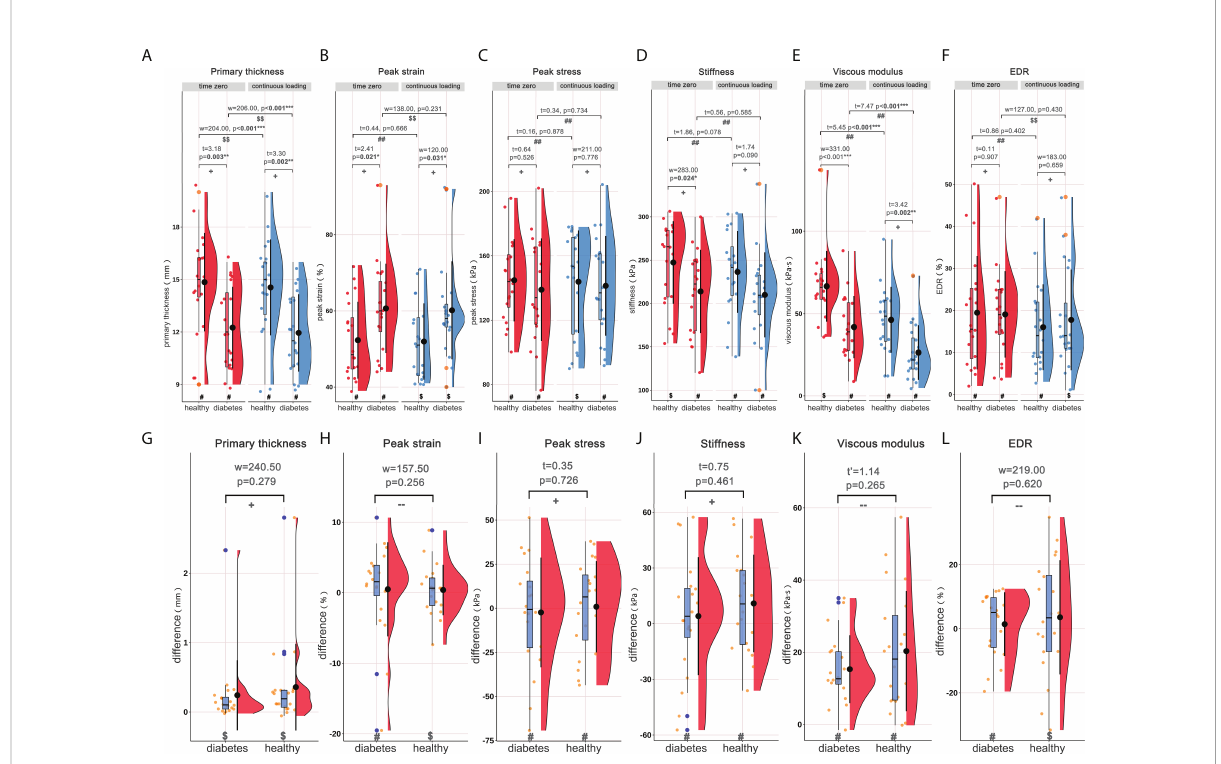
FIGURE 2 Rain-cloud plot depicting the material properties of heel pad, including primary thickness, peak strain, peak stress, stiffness, viscous modulus and EDR. (A – F) the material properties of heel pad in healthy and diabetes groups at time zero and following continuous loading. (G – L) the differences of material properties of heel pad between two loading statuses in healthy and diabetes groups. # , data follow the normality distribution; $ , data didn ’ t follow the normality distribution; ## , the difference between two loading statuses follow the normal distribution; $$ , the difference between two loading statuses didn ’ t follow the normal distribution; +, meet the homoscedasticity assumption; -, didn ’ t meet the homoscedasticity assumption. “ t ” , “ t ’” , and “ w ” represent the statistical effect sizes for T test, Welch ’ s T test, and Wilcoxon test, respectively. Error bar represents the mean value and standard deviation; box plot represent the median value and quartiles. EDR= energy dissipation rate. *, p<0.050; **p<0.010;